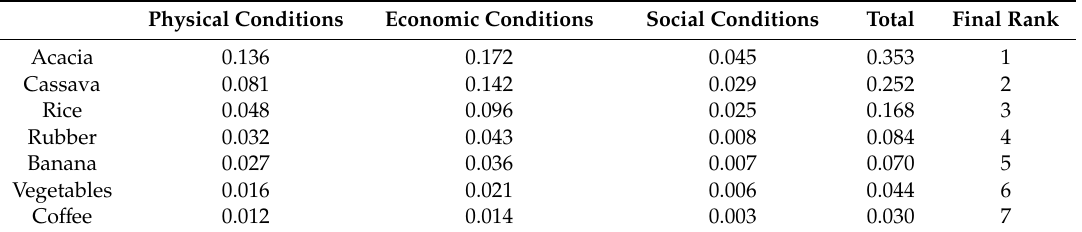
Table 7. Final Ranking of Crops in A Luoi District for Land Suitability Evaluation derived from Pairwise Comparison of